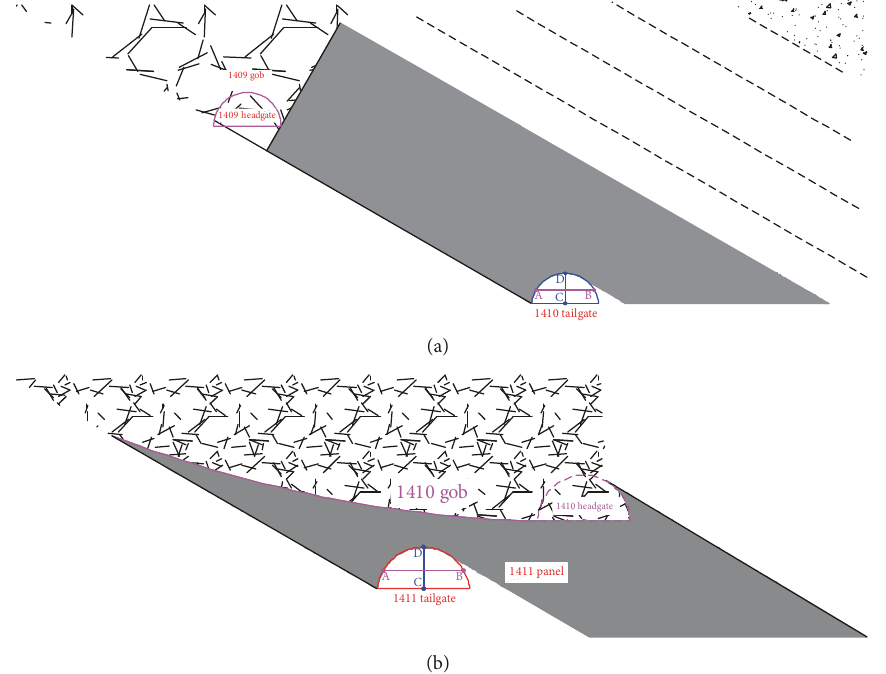
Figure 18: Cross-monitoring method. (a) Monitoring layout in 1410 tailgate. (b) Monitoring layout in 1411